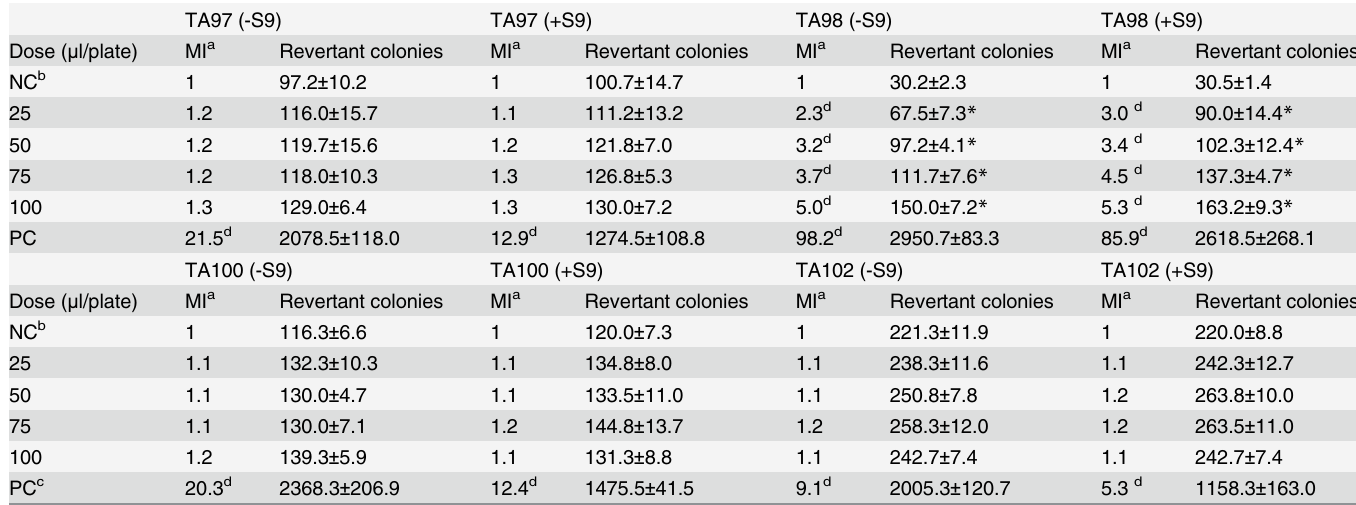
Table 2. The Salmonella bioassay of the irrigative wastewater taken from the Dongming discharging river in Shijiazhuang city (n = 6). TA97 (-S9)